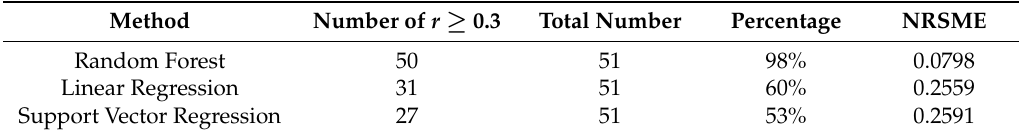
Table 4. Overall SH features predicted for the aggregated dataset of variables for both houses (IAQ 1_2)